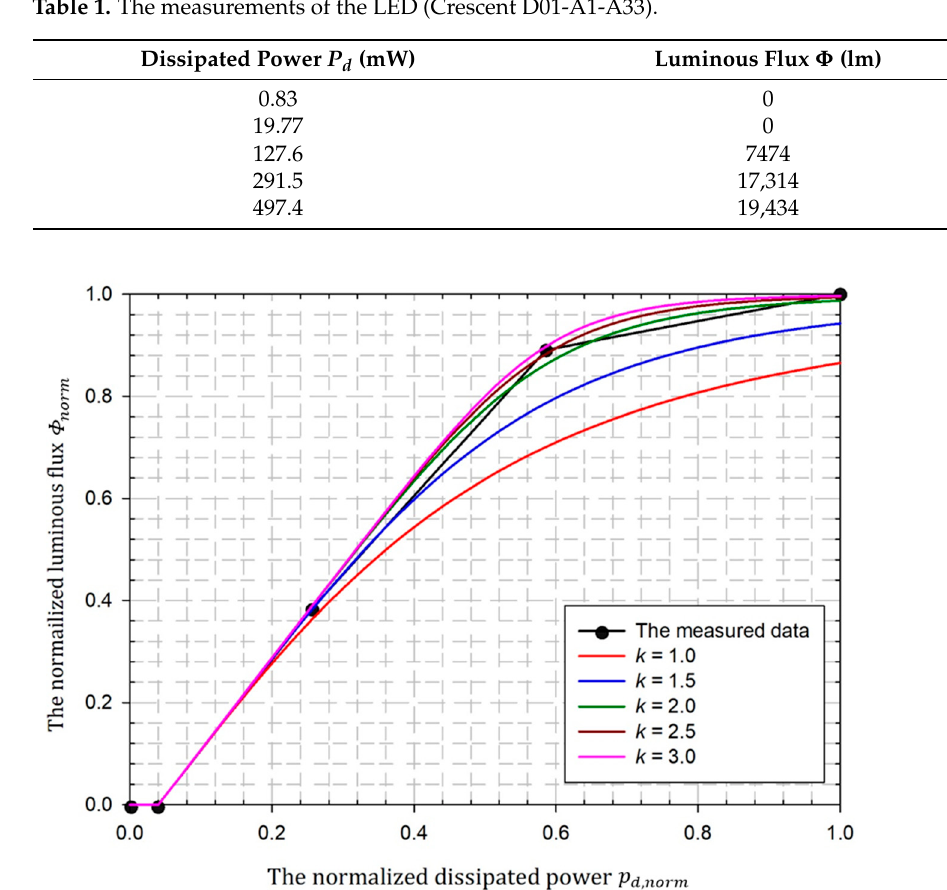
Figure 4. The characteristic function of the adopted LED. Table 1. The measurements of the LED (Crescent D01-A1-A33).